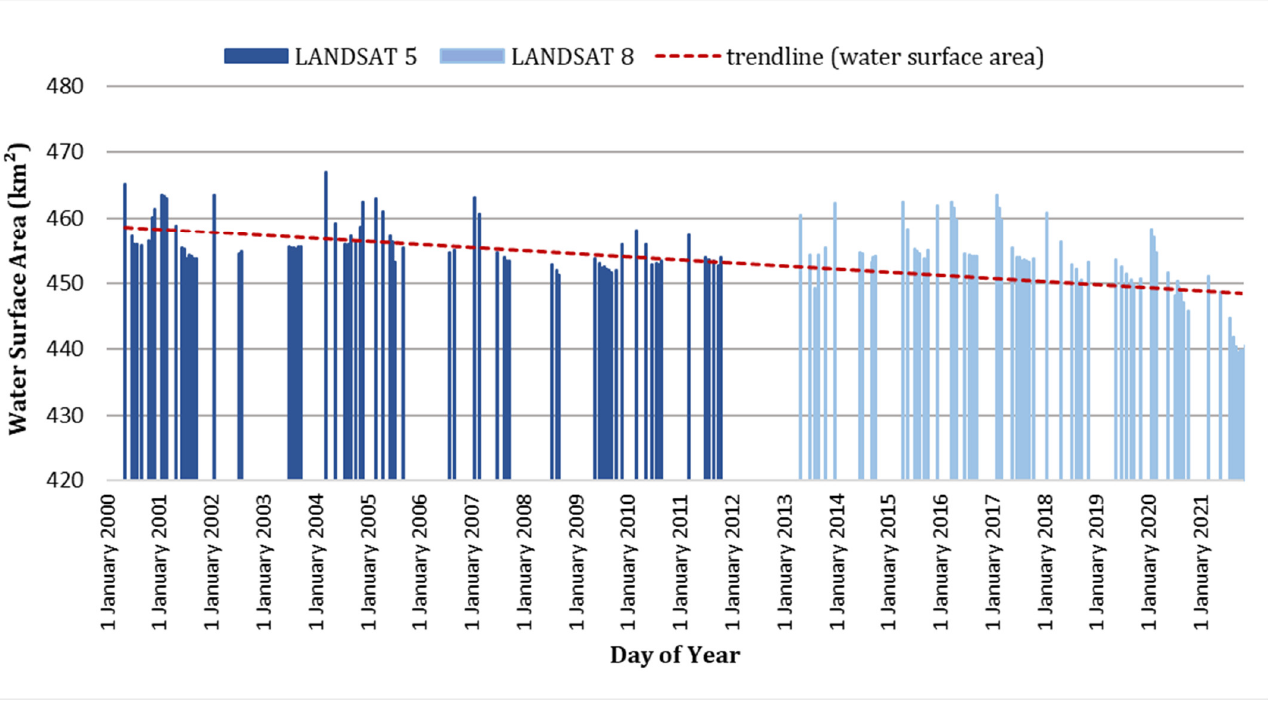
Figure 7. Water surface area temporal changes and trendline for Lake Egirdir between 2000 and 2021.